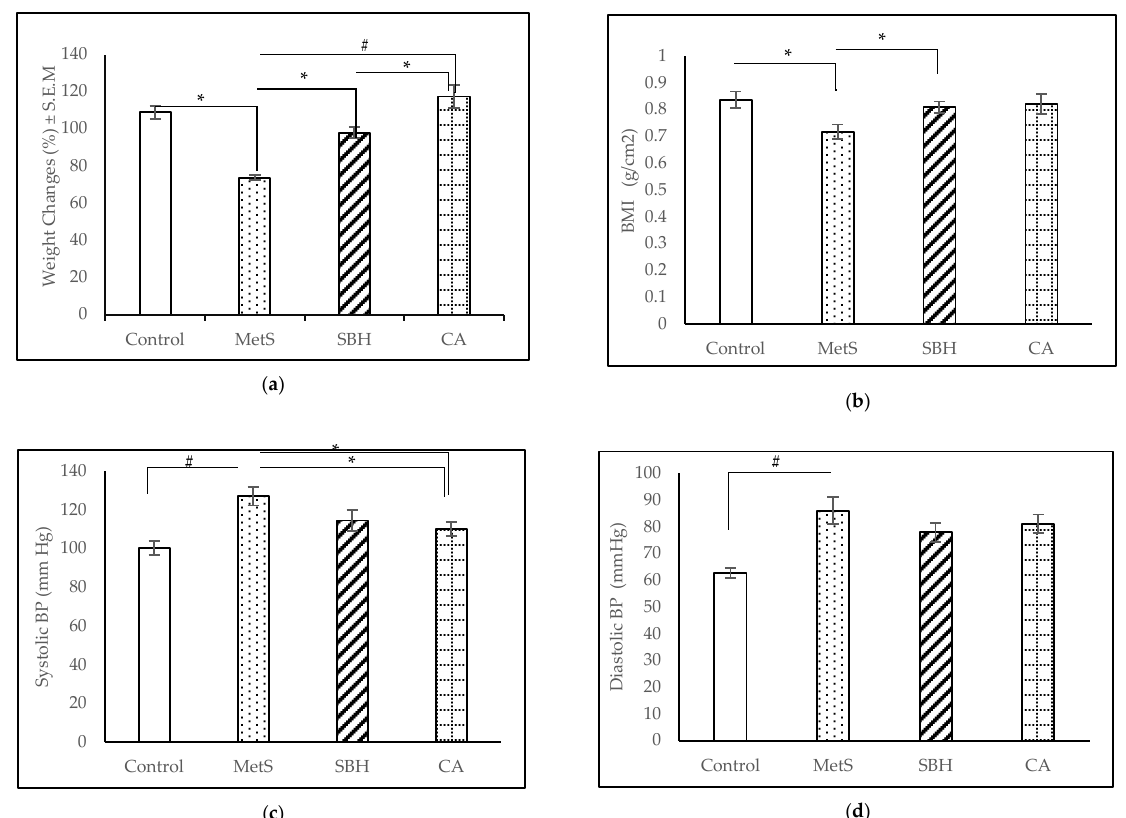
Figure 2. Effects of MetS induction and SBH and CA supplementation on physiological parameters of the experimented rats: changes in ( a ) weight; ( b ) BMI; ( c ) SBP; and ( d ) DBP. Data are presented as mean ± SEM ( n = 7). * p < 0.05; # p < 0.001.